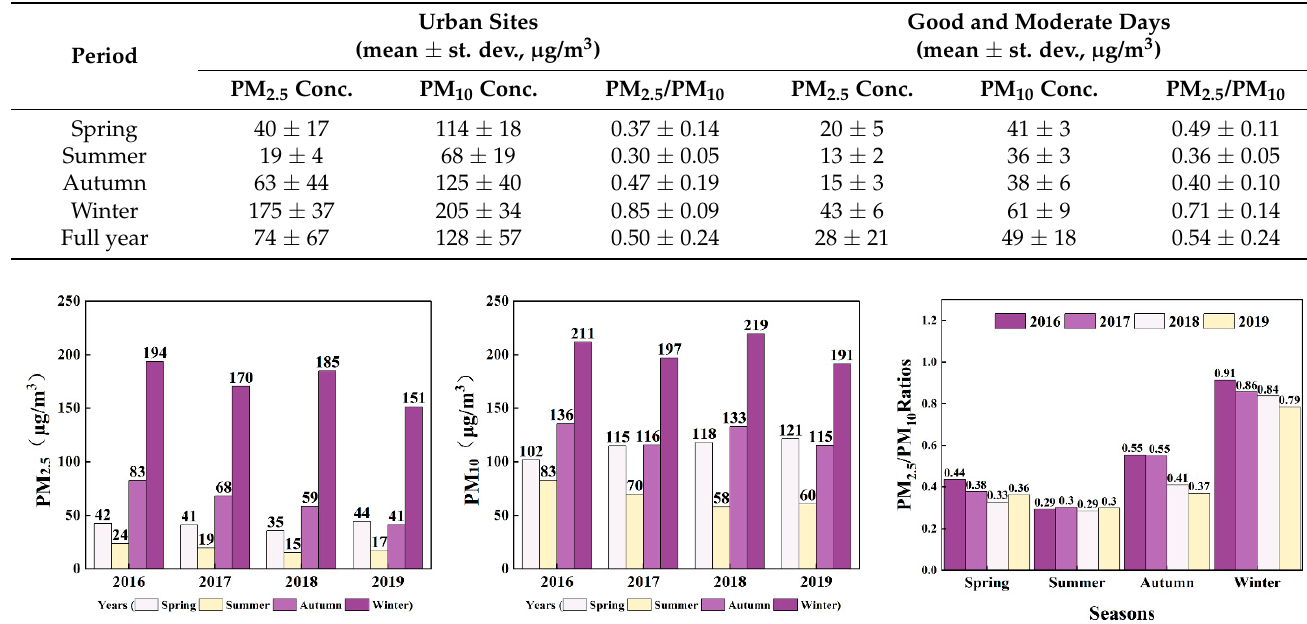
Figure 5. Seasonal changes in PM concentration and PM 2.5 /PM 10 ratio.